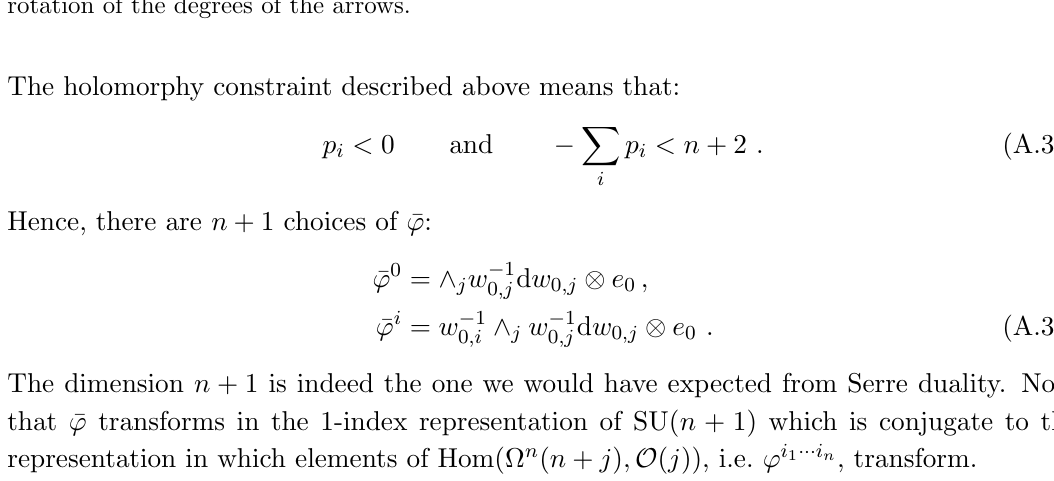
Figure 15. The transformation of (cid:13)avors upon a mutation on node ? can be implemented as a rotation of the degrees of the